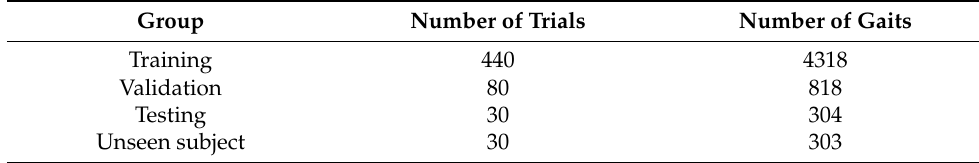
Table 1. Summary of dataset division.